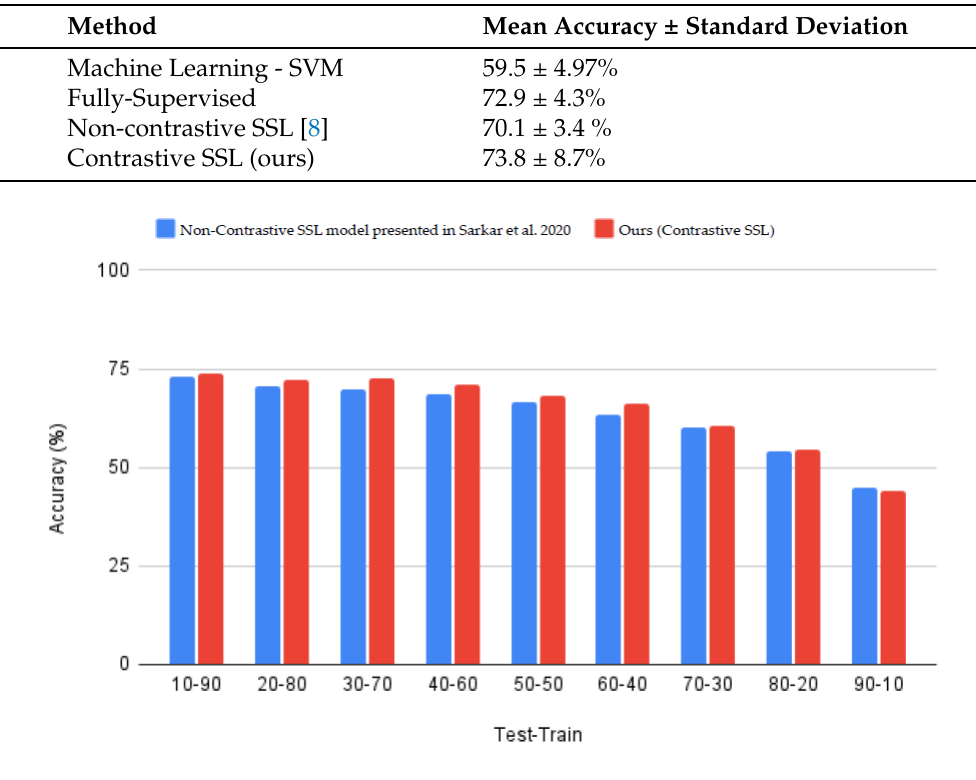
Figure 7. Contrastive SSL (proposed) vs. non-contrastive SSL [8] for varying test–train splits on the RML